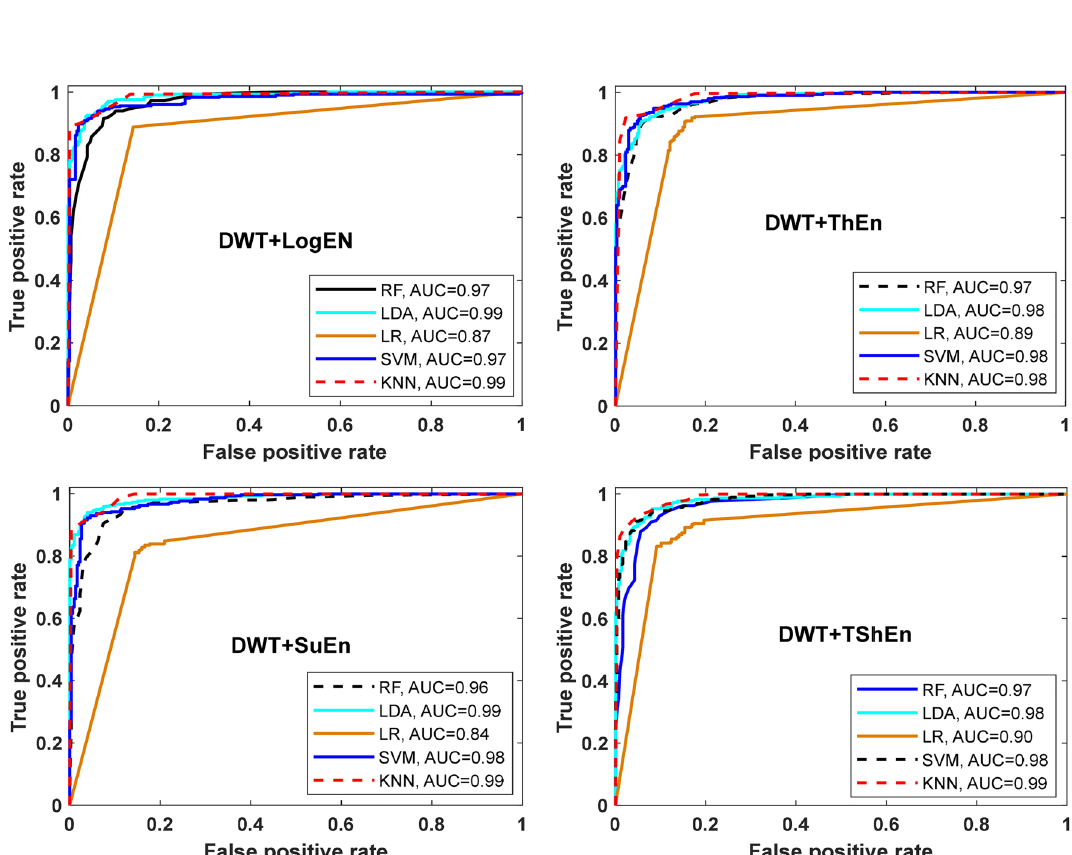
Figure 10. ROC-AUC of off- PD versus HC classification based on features extracted from four feature extraction